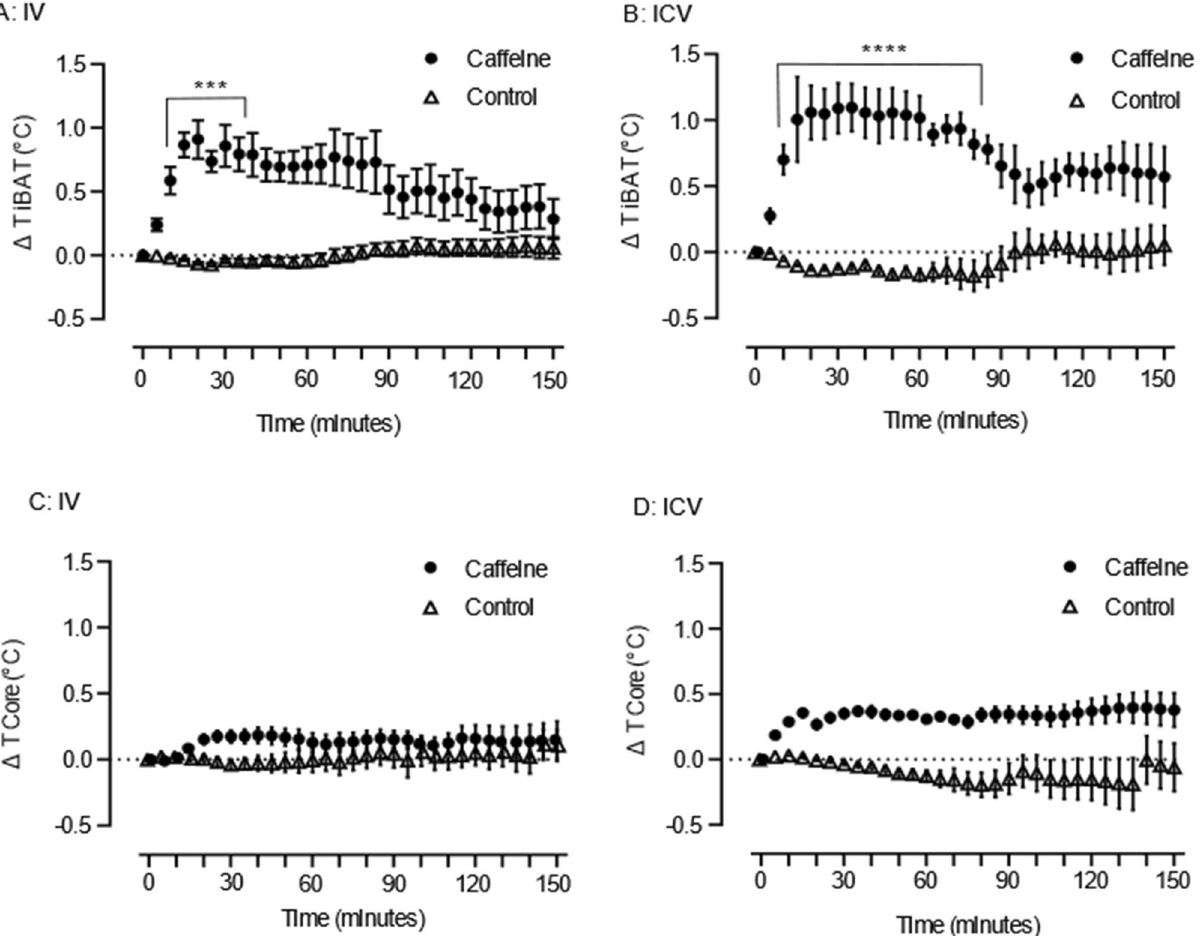
Figure 1. Changes in temperature (ΔT) of core and interscapular brown adipose tissue (iBAT) in rats following an administration (time = zero) of caffeine or vehicle alone to 150 min post treatment. Temperature of iBAT ( A ) IV administration † and ( B ) ICV administration. Core temperature ( C ) IV administration † and ( D ) ICV administration. Filled circle = Caffeine, open triangle = Control. Error bars represent S.E.M., n = 8 per intervention, *represents interaction effect (*** p < 0.001, **** p < 0.0001), † raw data shown in figure, but data were transformed prior to analysis (see “Materials and methods” tion with no change in temperature for the vehicle alone group. The peak increase in temperature for the caffeine group (1.1 °C ± 0.2 °C) was 25 min after administration. Similarly, ICV administration of caffeine (5–10 µg) saw a significant interaction effect (F (30, 420) = 3.5, p < 0.0001, Fig. 1B), with no change in temperature for the vehicle alone group. Increases in iBAT temperature (0.7 ± 0.1 °C) were at 10 min with a peak rise in temperature (1.2 ± 0.2 °C) at 30 min, this was sustained until 85 min (0.9 ± 0.2 °C). Neither IV nor ICV caffeine administration evoked changes in core body temperature (IV: F (30, 420) = 0.8 , p = 0.6; Fig. 1C ICV: F (30, 330) = 0.9 , p = 0.5; Fig. 1D). Dose of caffeine used does not significantly change heart rate or mean arterial pressure. To test whether the dose of caffeine affected cardiovascular responses, in response to either route of administra- tion of caffeine, heart rate and mean arterial pressure were measured via intra-arterial catheter. Analysis was conducted separately for IV and ICV administration. Baseline heart rate and mean arterial pressure data are summarised in Table 1 . Temperature and cardiovascular measures remained stable for 30 min prior to drug administration and there was no observed difference in baseline conditions prior to intervention. Neither IV or ICV administration of caffeine changed heart rate compared to vehicle alone over time (interaction effects: IV: F (30, 420) = 1.0 , p = 0.4, Fig. 2A; ICV: F (30, 330) = 0.3 , p = 0.9, Fig. 2B). Systemic (IV: Fig. 2C) or central (ICV: Fig. 2D) administration of caffeine had no effect on mean arterial pressure compared with vehicle alone (interaction